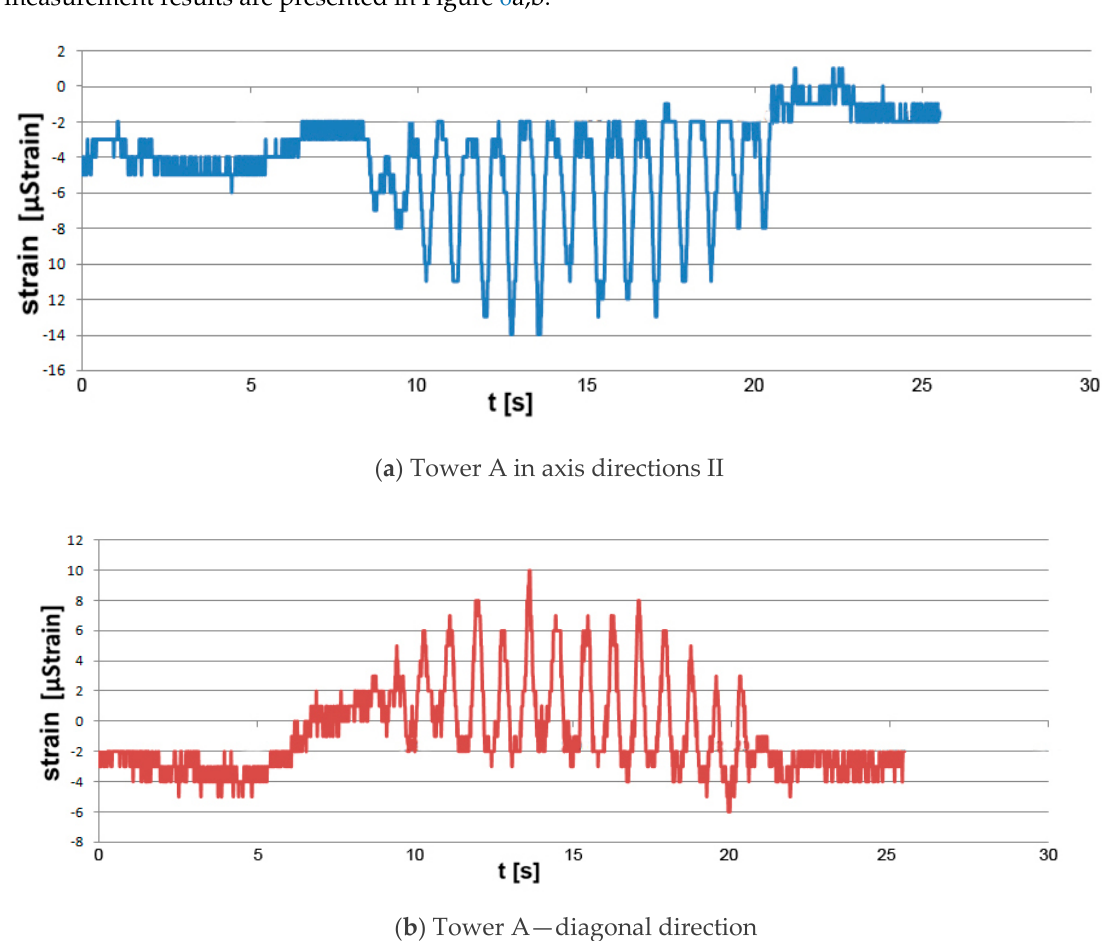
Figure 6. Strains in the legs of tower A under a lateral load: ( a ) in the tower axis direction, ( b ) in the tower diagonal direction.